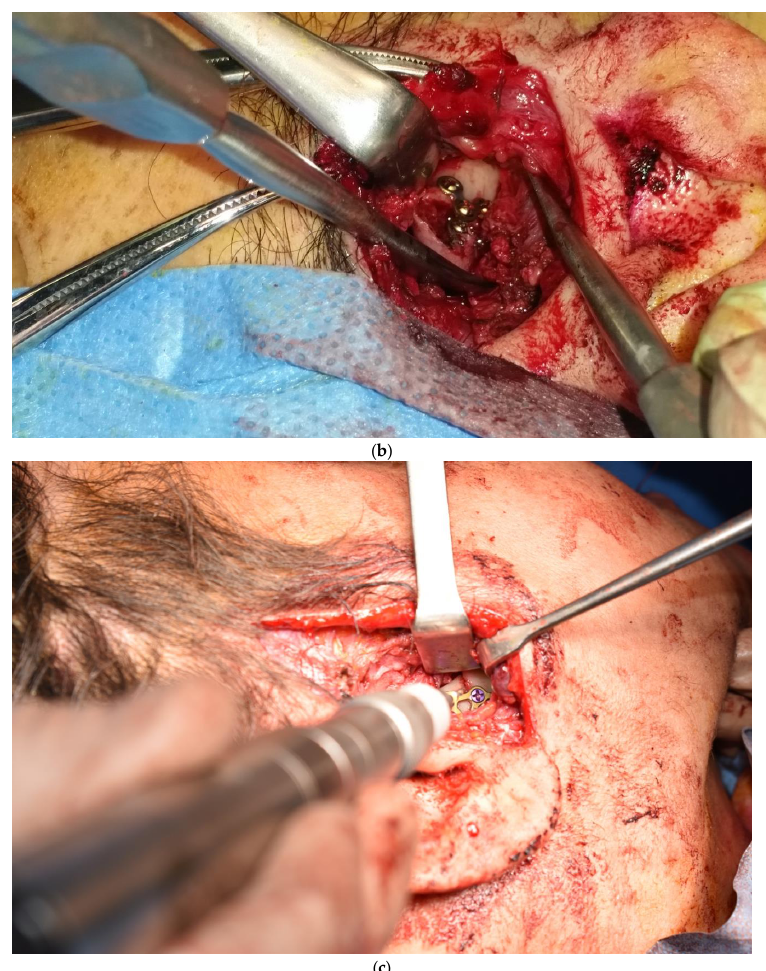
Figure 5. ( a ) Condylar head reduction by screw insertion for safe managing. ( b ) Condylar head fixation. ( c ) Condylar head fixation after lower screws fixation on the ramous. In particular, the posterior sub-condylar area was visible by preauricular incision, while the anterior sub-condylar area was also visible through intraoral mucosa access. Moreover, surgical scars in the aesthetic areas of the neck following current techniques were avoided. Cutaneous incision starts on the upper end of the helix proceeding in the pre-auricular area, extending to the tragus and the surgical path proceeded by deeply reaching the auricular cartilaginous plane and the TMJ capsule. Following opening of the TMJ capsule, we could find the condylar fragment that usually was dragged medially and anteriorly by the insertion of the lateral